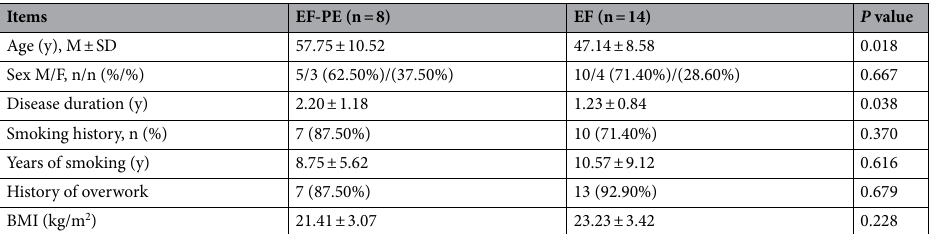
Table 1. Demographic characteristics of the two groups. Comparisons were determined by Student’s t test or the Mann–Whitney U test, chi-square test or Fisher’s exact test. P < 0.05 was considered statistically significant. M male, F female, BMI body mass index, M ± SD mean ± standard